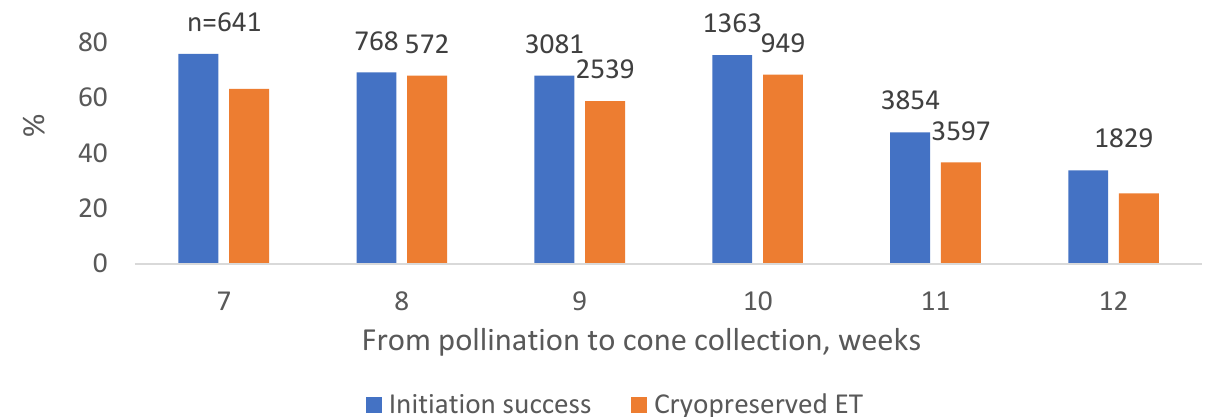
Figure 4. Norway spruce SE initiation success percentages from 2011 to 2022, and the percentage of initiations which led to cryopreservation from 2014 to 2022 in different cone development duration.